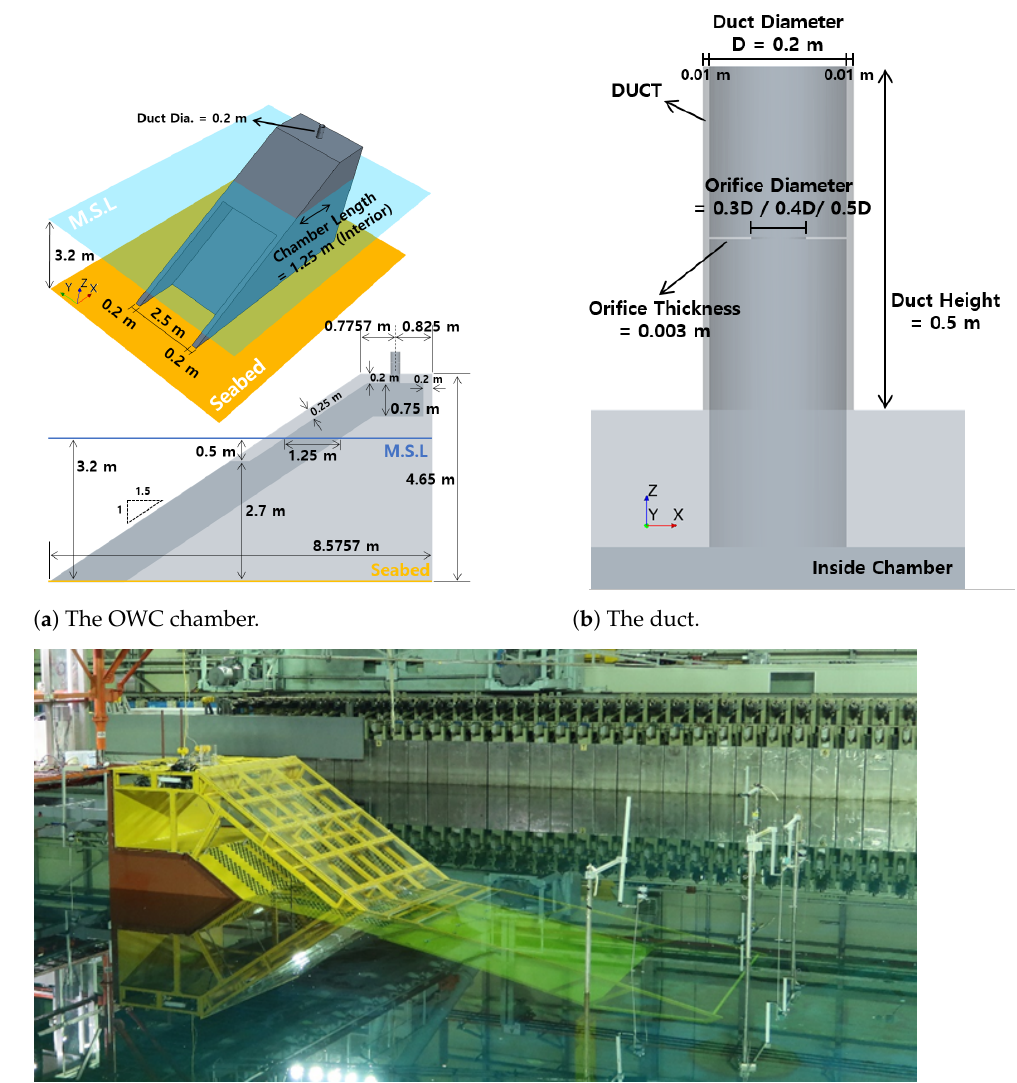
Figure 4. The particulars of the chamber model used in the experiment: ( a ) chamber geometry and dimensions; ( b ) duct dimensions; and ( c ) the installed model in the